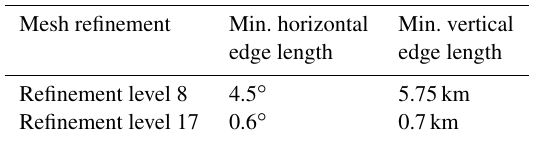
Table 4. Minimum edge length of the tetrahedra in the horizontal and vertical direction. Mesh refinement Min. horizontal Min. vertical edge length edge length Refinement level 8 4.5 ◦ 5.75km Refinement level 17 0.6 ◦